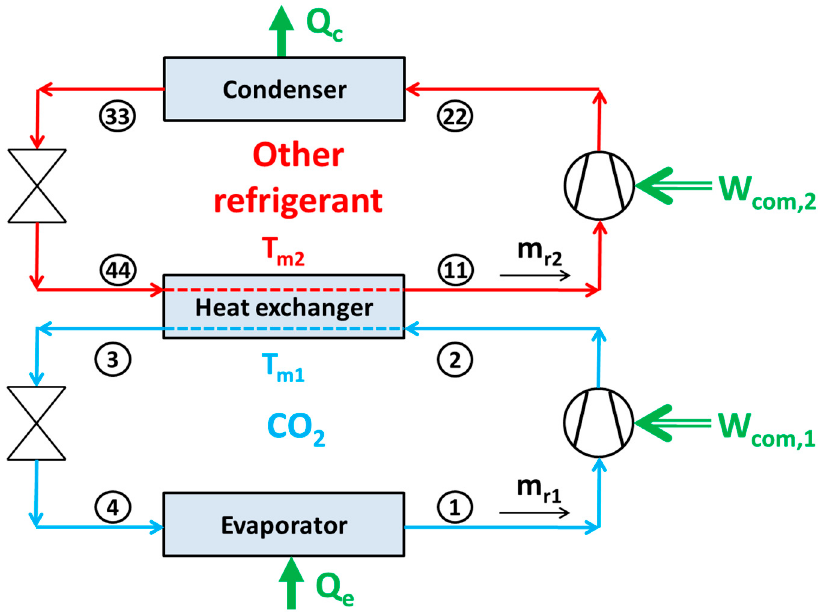
Figure 1. The examined cascade configuration.